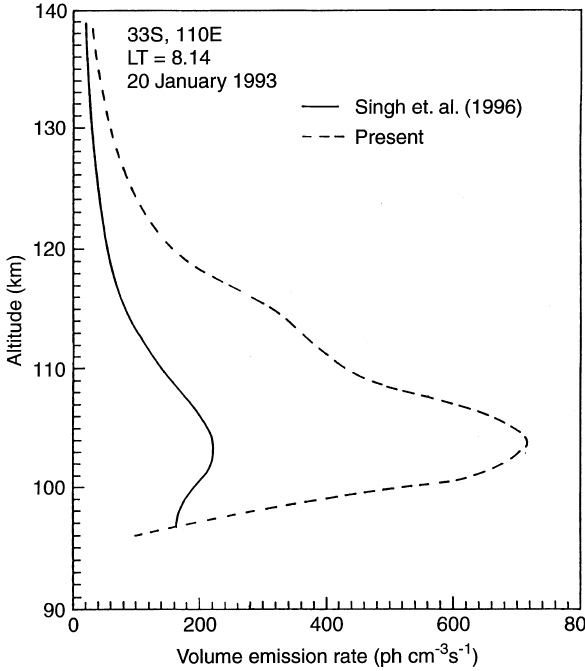
Fig. 4. Relative variation of greenline dayglow emission rates obtained from the present model and Singh et al . (1996) model for the photodissociation of O